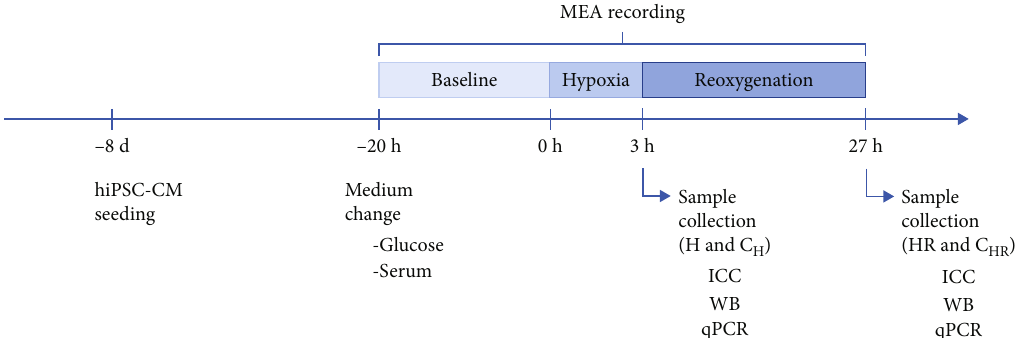
Figure 2: Timeline of the experiments. hiPSC-CMs were seeded on 1-wells on glass or MEA 8 days before hypoxia start. Glucose- and serum-free medium was exchanged to the samples on the day before the hypoxia start. 0% O which samples (H) were collected for immunocytochemistry (ICC), western blot (WB), and qPCR, or 19% O induced to the samples. After 24-hour reoxygenation, samples (HR) were collected for ICC, WB, and qPCR. Control samples were kept in a standard incubator for the duration of the hypoxia (C after medium exchange, after which 0% O in 19% O 2